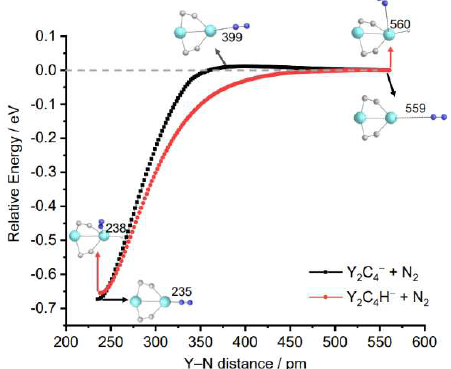
Figure 3. The BPW91−calculated relaxed potential energy curves of N 2 approaching Y 2 C 4− and Y 2 C 4 H − anions. Y 2 C 4 H −